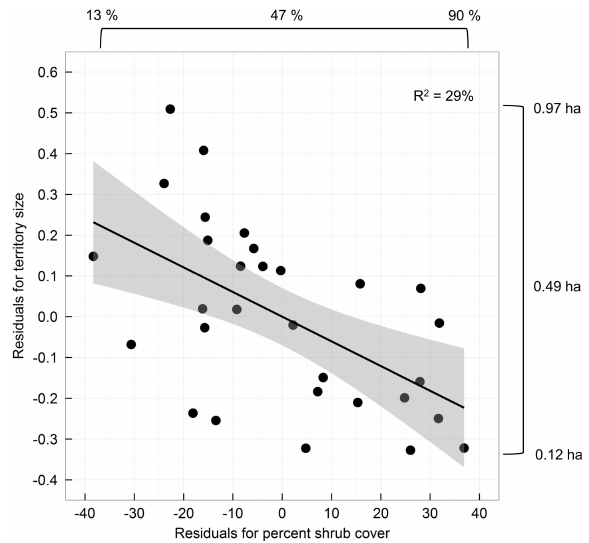
Fig. 3 . Partial residual plot illustrating the relationship between percent shrub cover and territory size. The grey area represents the 95% confidence interval for the fitted values. The bracket on the top, from left to right, illustrates the minimum, median, and maximum percent shrub cover measured at the center of each territory, respectively. The bracket on the right, from top to bottom, illustrates the maximum, median, and minimum measurements for territory size (ha; 50% KDE contour),